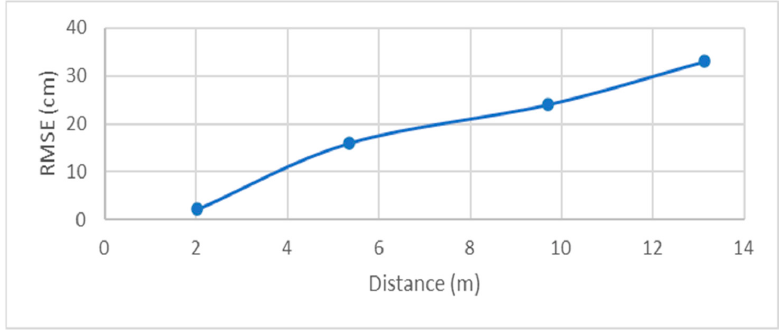
Figure 13. Effect of distance to marker on placement accuracy for Vuforia SDK. The distance effect is generally negligible when using the ARcore SDK, which is char- acterized by the anchor functionality in the augmented model (Figure 14).